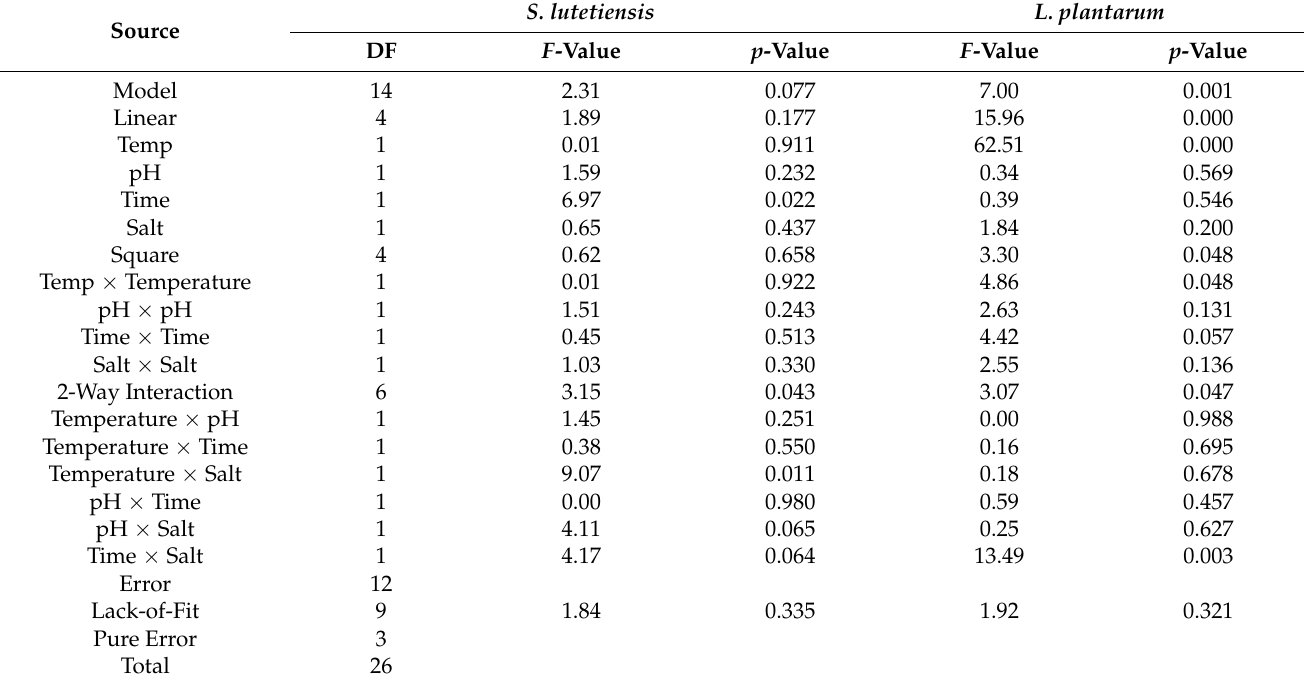
Table 2. Analysis of variance for S. lutetiensis and L.